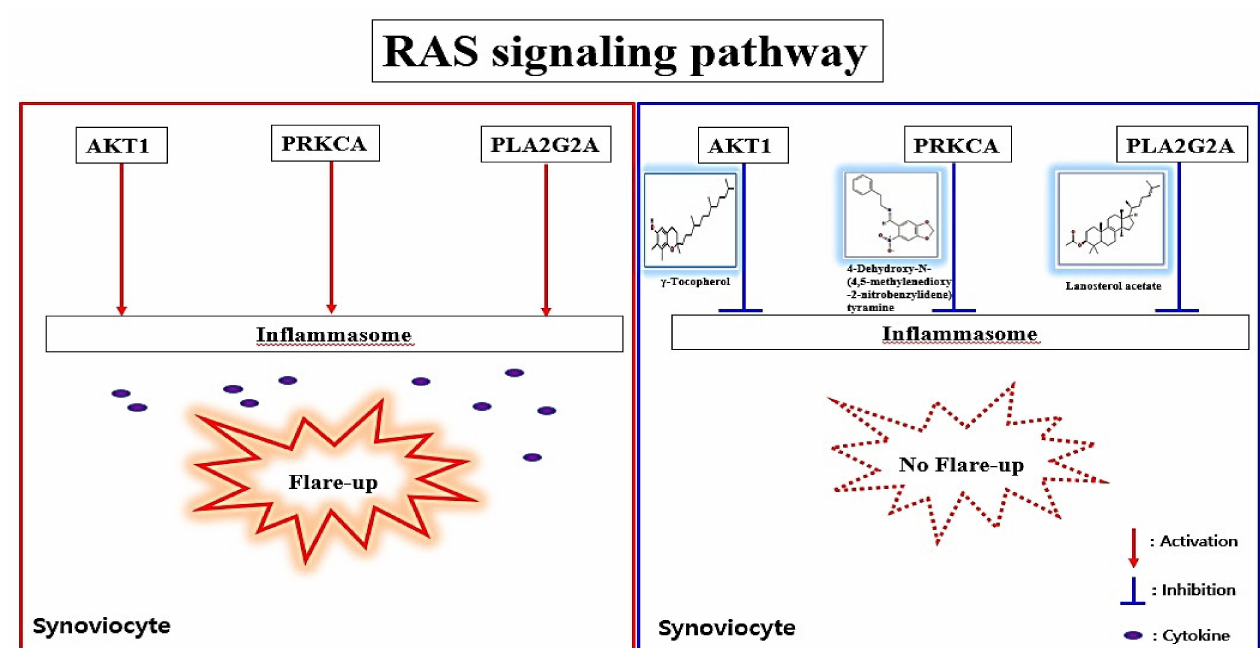
Figure 10. Summary figure of key findings in the